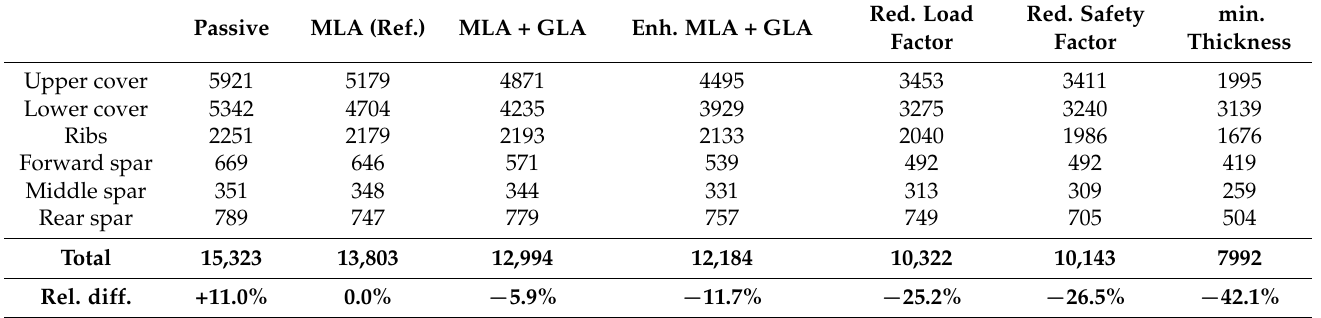
Table A2. Overview of the wingbox primary structural mass in kg.